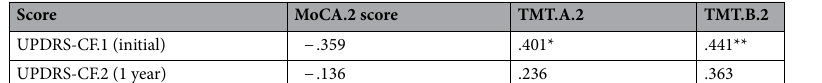
Score MoCA.2 score TMT.A.2 TMT.B.2 − .359 − .136 .363 Table 2. Correlations between the first and second UPDRS-CF and second MoCA and neuropsychological test scores (TMT). *Correlation is significant at p ≤ .02 after Bonferroni correction; ** p < .01.